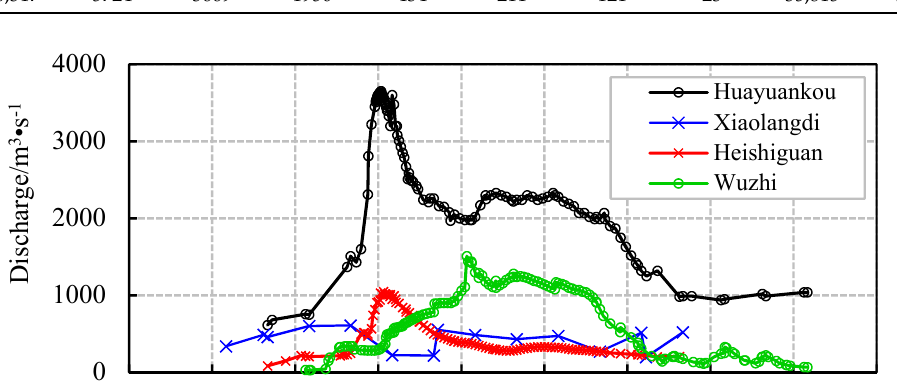
Figure 3. Location of rainfall stations. 2.3. Method The ultimate aim of the hydrology frequency calculation is to determine the design value corresponding to the given design frequency. It stipulates that the line type of the frequency curve generally adopts Pearson-III distribution in the code for calculation of design flood of water conservancy and hydropower project [48]. The P-III curve is an unsymmetrical single-peak and positive partial curve with one infinite end. The probability density function of the Pearson-III curve is written as follows [49,50]: